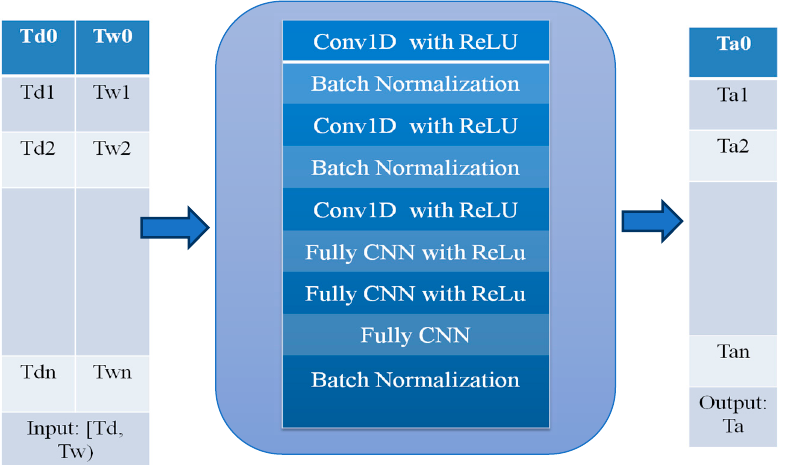
Figure 2. CNN model in Proposed Hybrid Model.